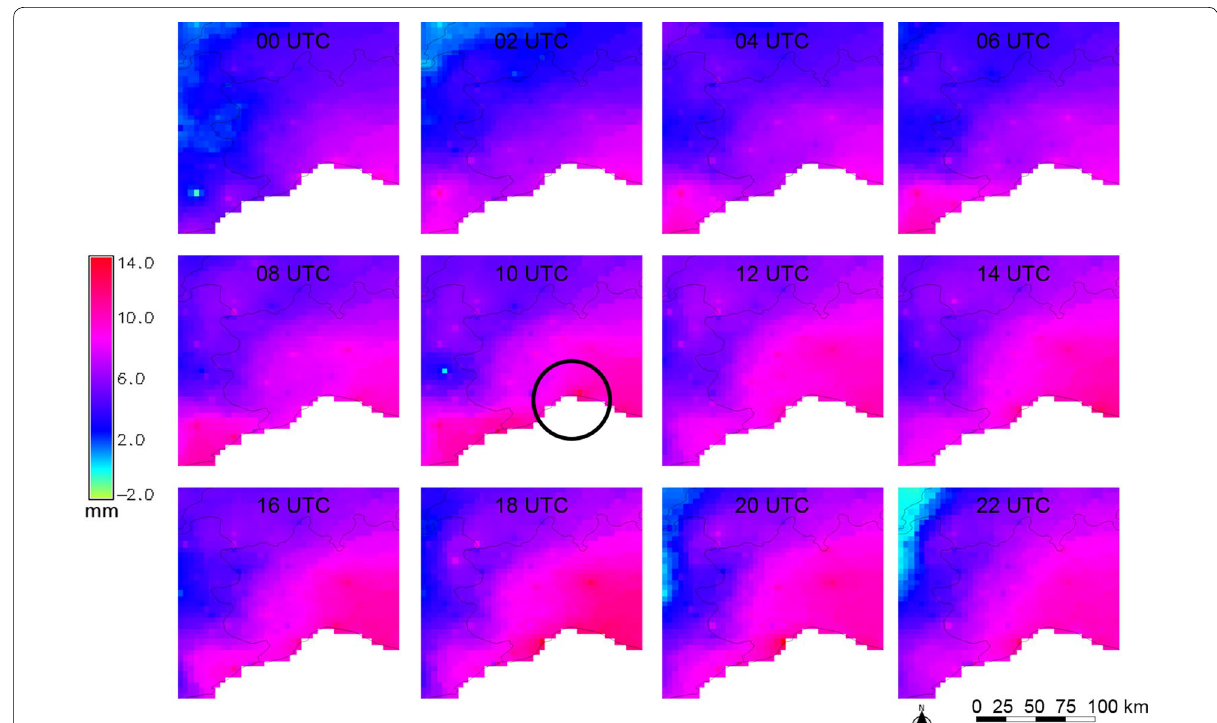
Fig. 13 ΔPWV maps for November 4, 2011, from 00:00 to 22:00 UTC, differentiated with respect to November 3, 2011, 02:00 UTC